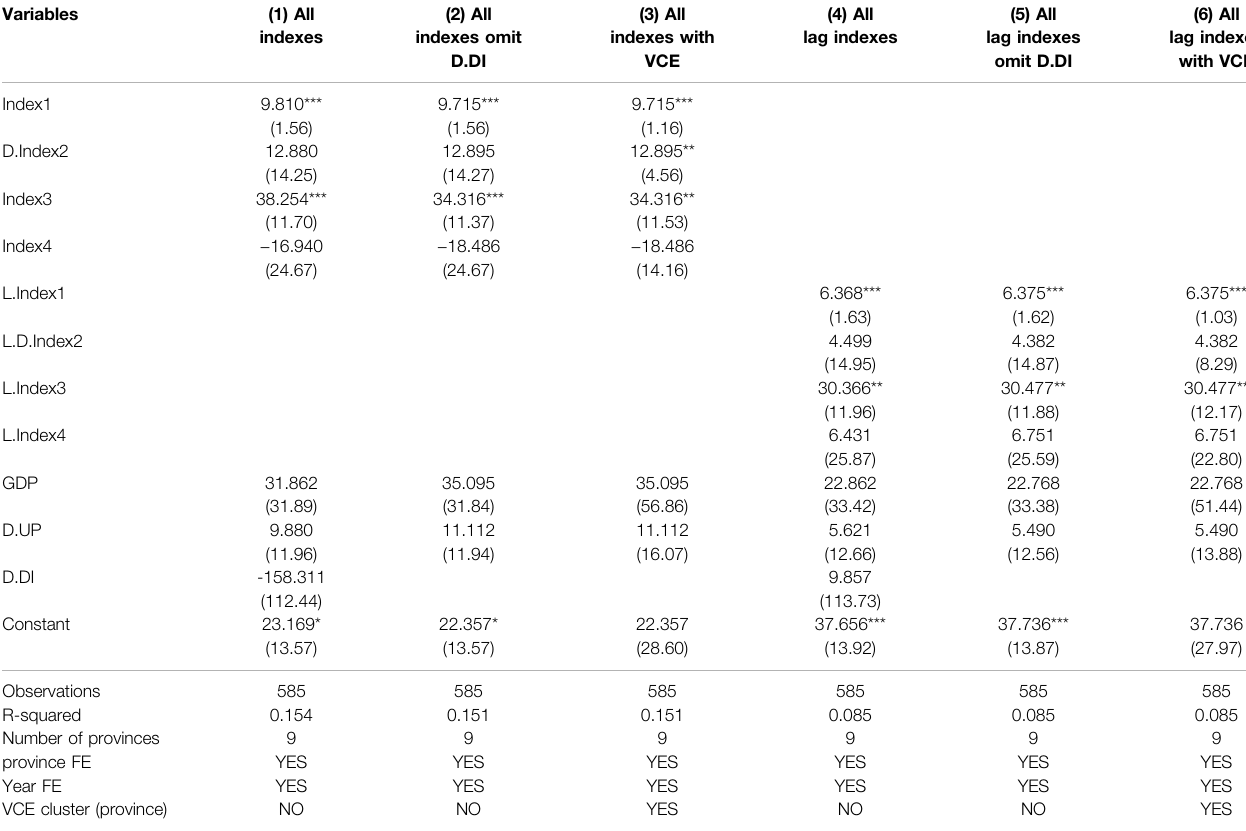
TABLE 6 | Model estimation results using Baidu search index regarding the east district of China.